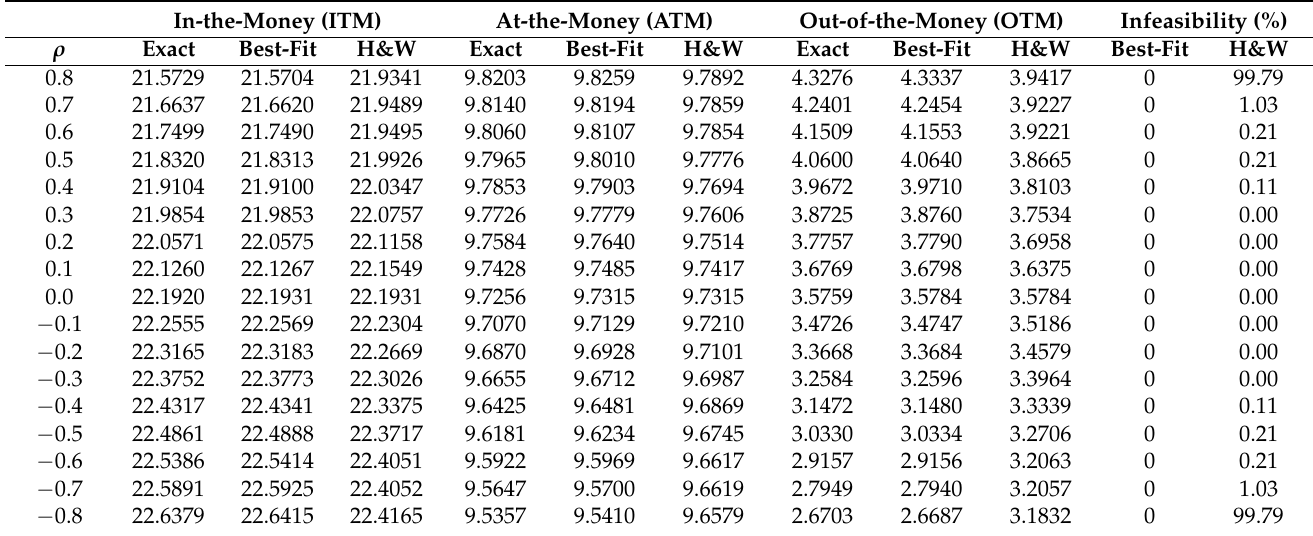
Table 4. Impact of lattice infeasibility on options